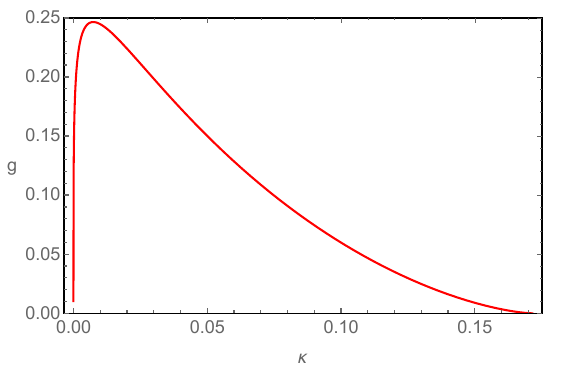
Figure 6 . Coe(cid:14)cient g ( (cid:20) ) in (cid:14) min (cid:24) e (cid:0) g ( (cid:20) ) N , in limit K; N ! 1 , (cid:20) = K